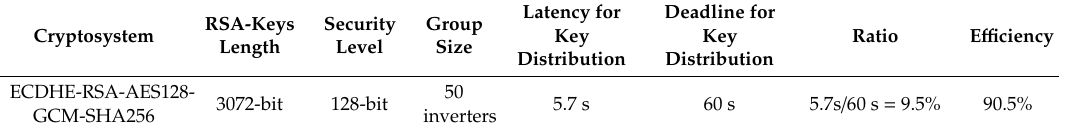
Table 4. Latency for group key distribution: main